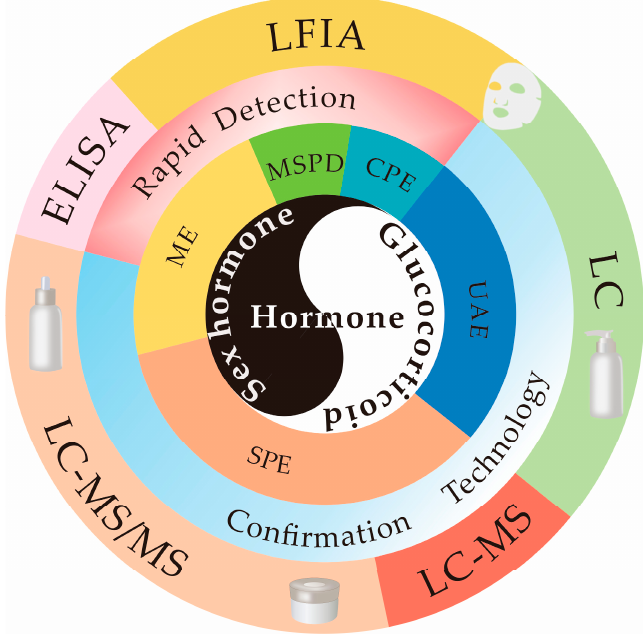
Figure 1. Sample preparation and detection techniques for hormones in cosmetics are included in this review.